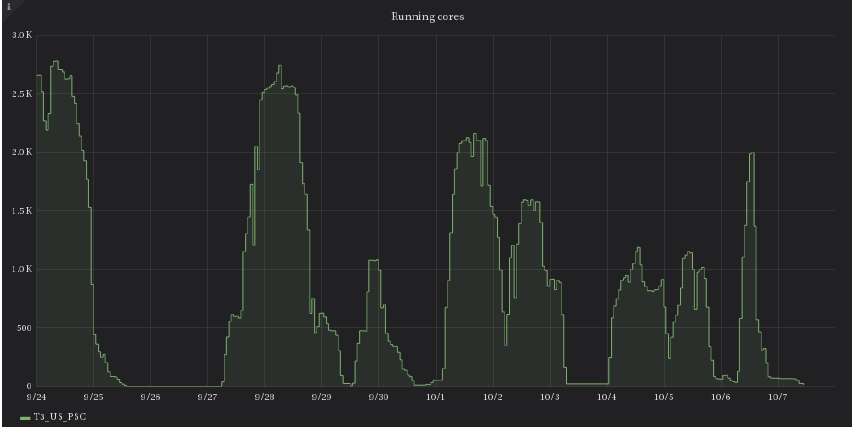
Figure 5. Cores in running CMS jobs at